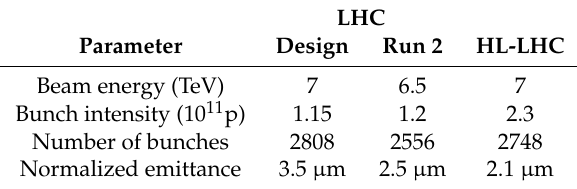
Table 1. LHC design, LHC Run 2 and HL-LHC parameters for the most critical beam (BCMS